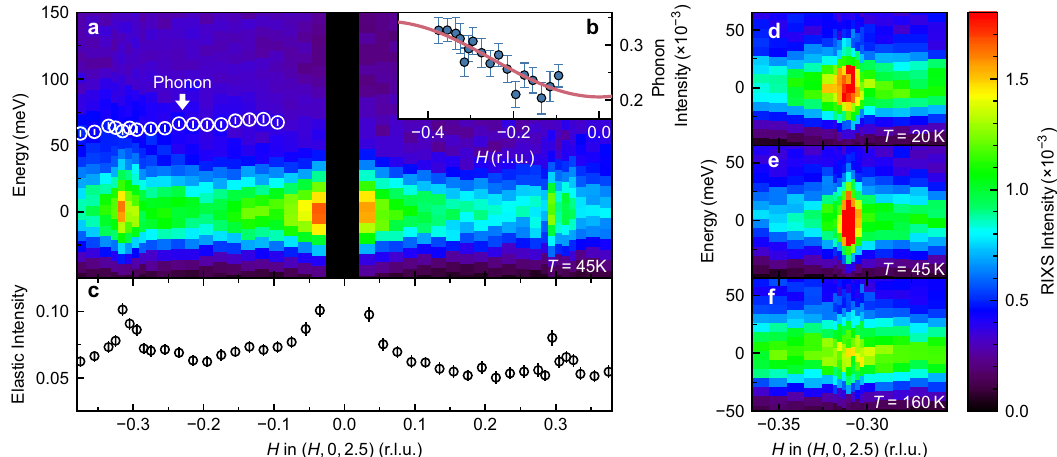
Fig. 2 RIXS intensity maps. Maps for p = 0.25 sample taken at 45 K. a H − E map over the H range ± 0.375. White circles are the energies of the feature in Fig. 1 b , c believed to be a phonon and the intensity of the feature is plotted in b , along with a line proportional to sin 2 ð π H Þ in red. c The elastic intensity obtained by integrating the RIXS intensity between − 100 < E < 100 meV, and dividing by the integral between 1000 < E < 3000 meV. Peaks at H ≈ ±0.31 are due to the charge density wave. d – f are RIXS intensity maps of the peak centred at H ≈ − 0.31 at different temperatures.